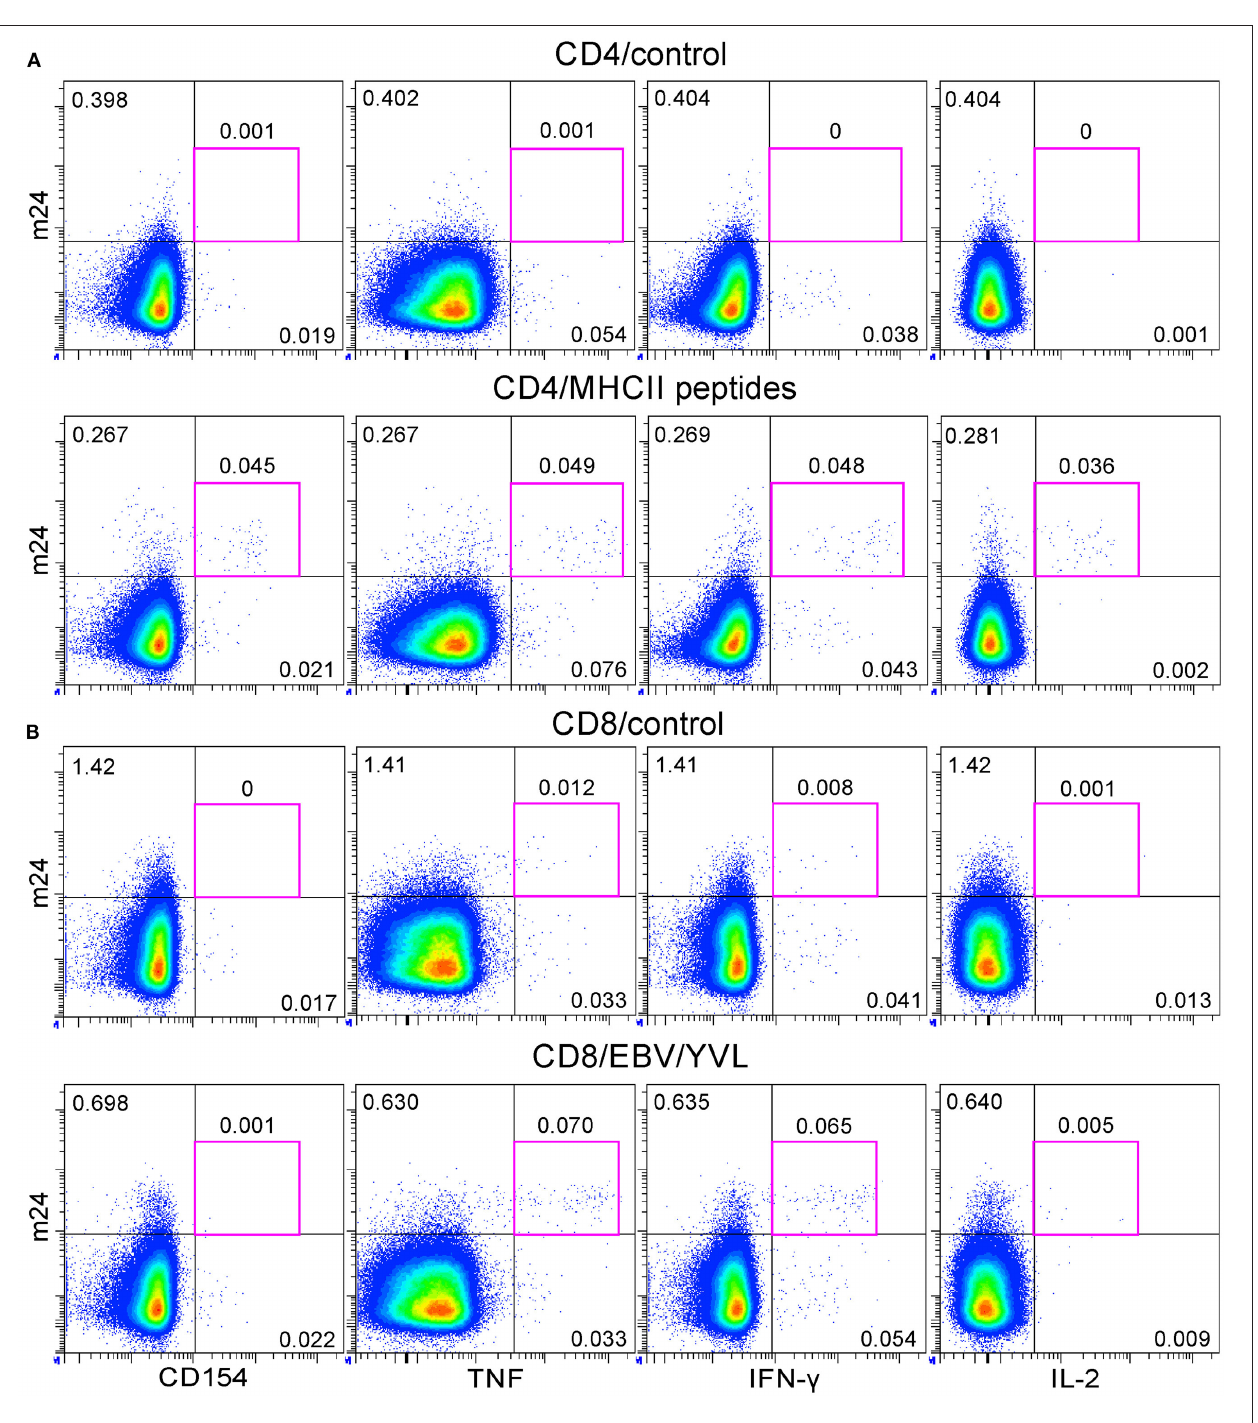
FIGURE 10 | The application of the m24 Ab assay for simultaneous detection of antigen-specific CD4 + and CD8 + T cells within cryopreserved peripheral blood mononuclear cells (PBMCs). PBMCs of a preselected healthy donor were thawed and rested overnight before a 4h stimulation with a pool of HLA-class II and HLA-A*02 peptides. (A) m24 Ab staining and CD154, TNF, IFN- γ , and IL-2 expressions for unstimulated (control) or major histocompatibility complex (MHC)-class II peptide-stimulated CD4 + T cells (mix of n = 9 virus-derived peptides). (B) The same stainings for CD8 + T cells without stimulation (control) or after stimulation with a HLA-A*02 epitope (YVLDHLIVV and EBV/YVL). Gating strategy is similar to that of Figures 1A , 2A , with Zombie Aqua included as a live/dead cell marker. See also Supplementary Figure 5A .